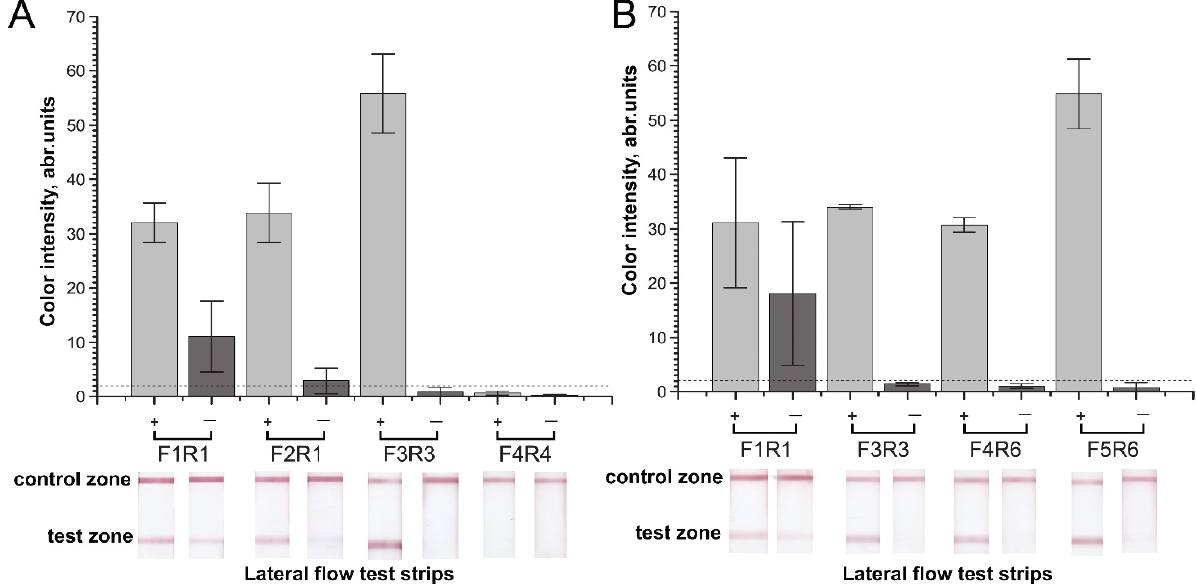
Figure 2. Effect of the primer pair in RPA–LFA for total DNA isolated from chicken ( A ) or pig ( B ) meat and nontarget DNA. Color intensities of the test zones and corresponding scans of the test strips. “+”—positive meat control, “ − ” negative—control (nontarget DNA). The dashed line represents the signal visible to the naked eye (2 a.u.).